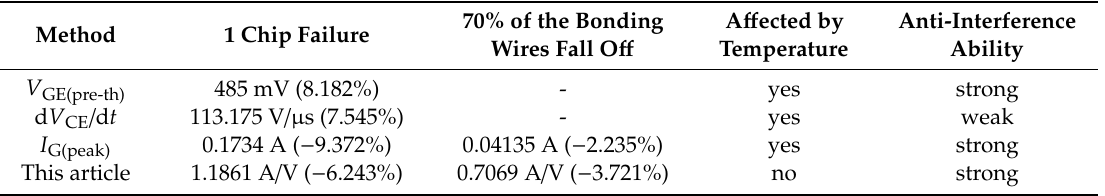
Table 12. Comparison of IGBT module chip fault monitoring